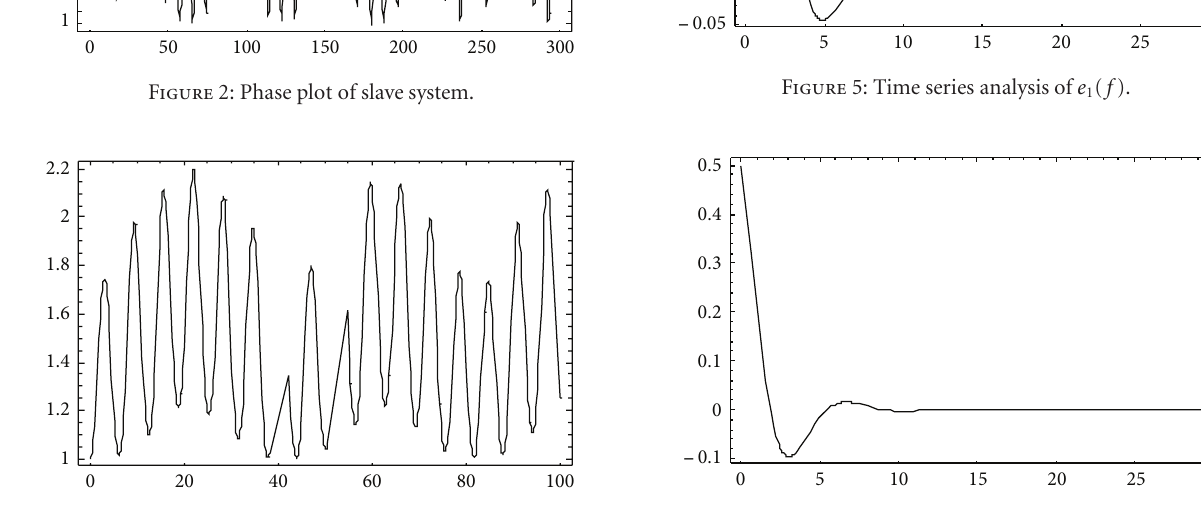
Figure 3: Time series analysis of master system.